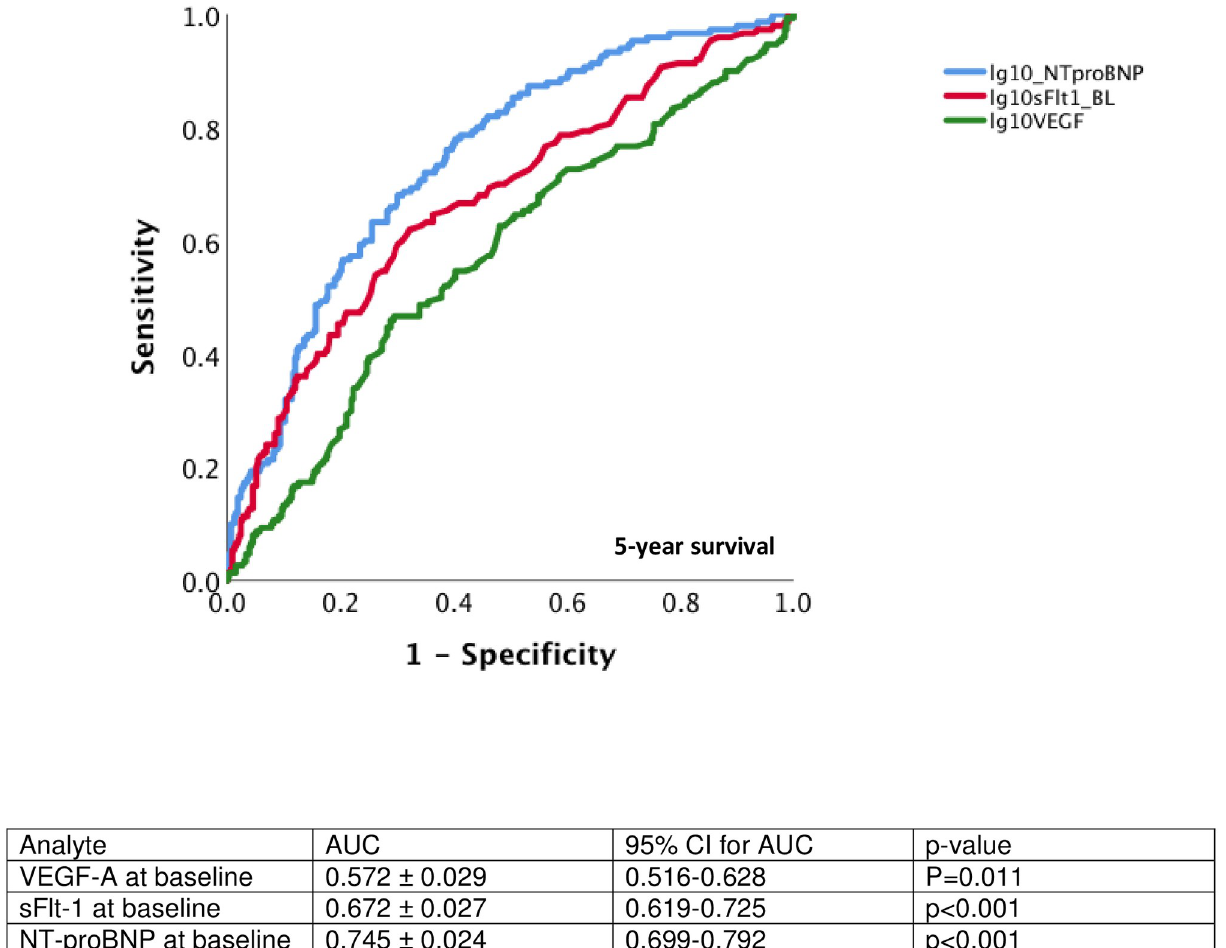
Fig 2. Receiver-operator curve analysis of VEGF-A, sFlt-1 and NT-proBNP as predictors of survival at 5 years in the CDCS cohort.